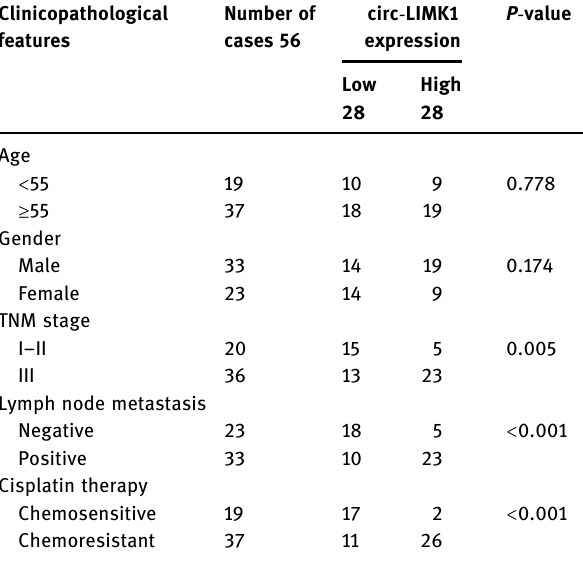
Table 1: Clinical characteristics of lung adenocarcinoma patients according to high and low circ - LIMK1